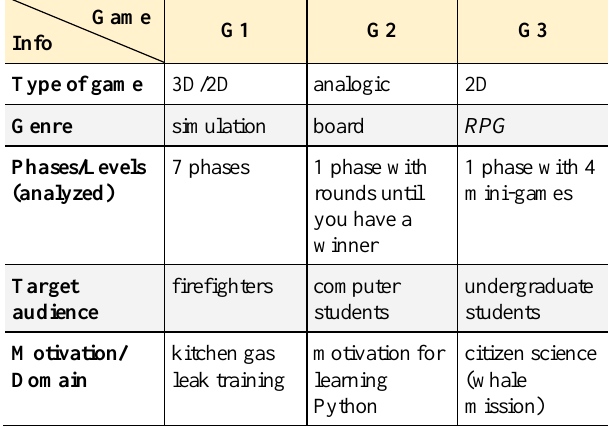
Table 2. Comparison of the analyzed